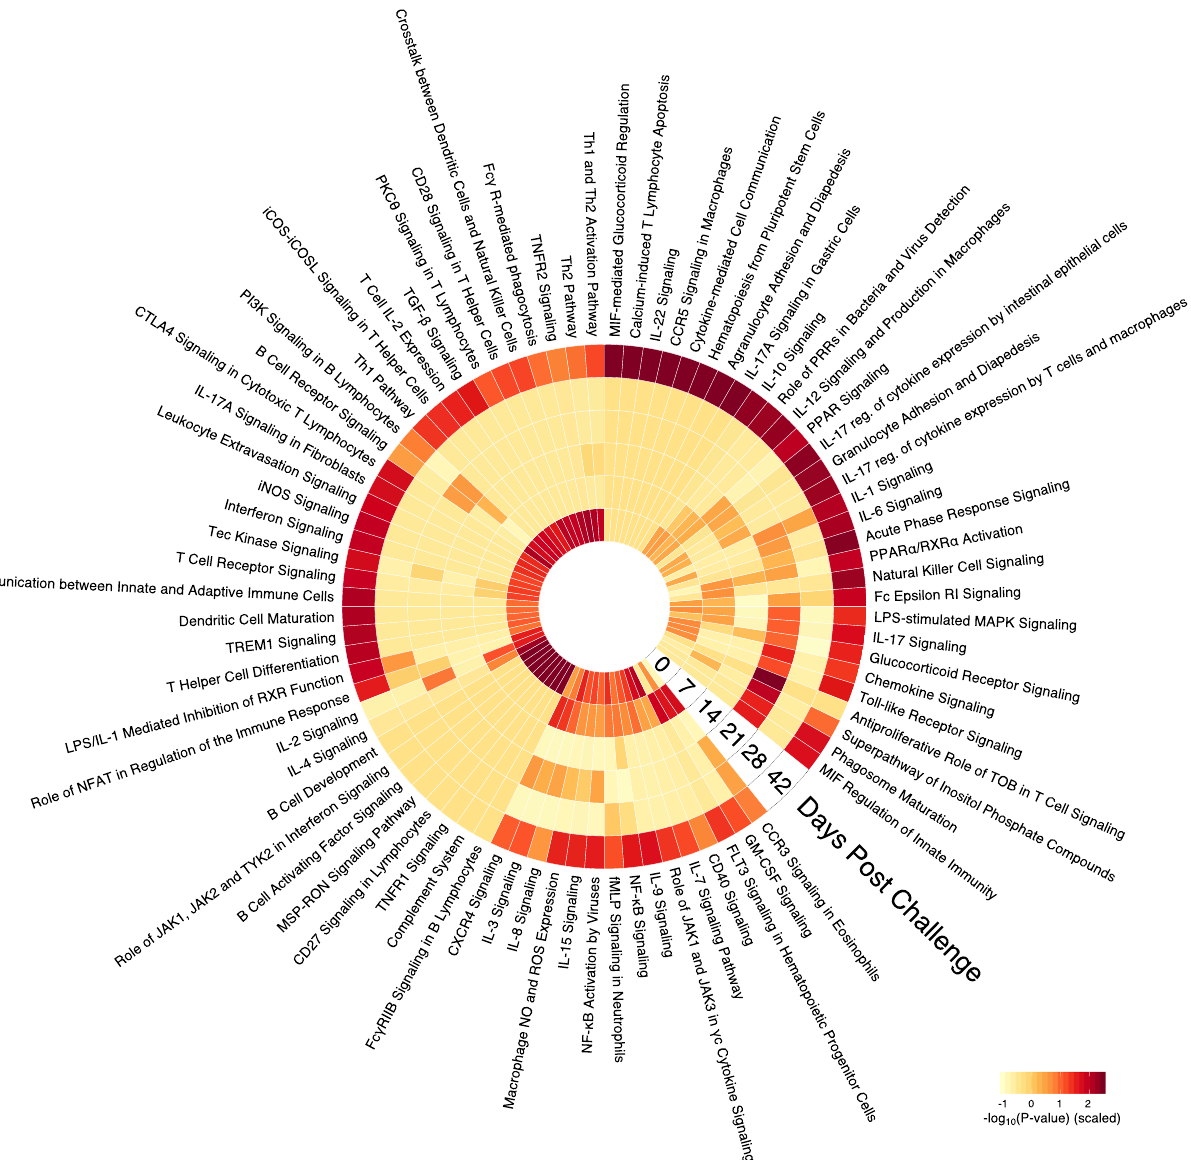
Fig. 2 Temporal dynamics of the expression of immune pathways that predict either post-mortem worm burden or cFEC identi fi ed by supervised machine learning ElasticNet. Heat map indicates the pathway enrichment reported as negative log P (cid:1) value denotes stronger enrichment within each pathway. Each concentric circle represents one of six time-points at which abomasal biopsies were taken after challenge infection. Worm burdens predicted by these pathways were measured at D49 post